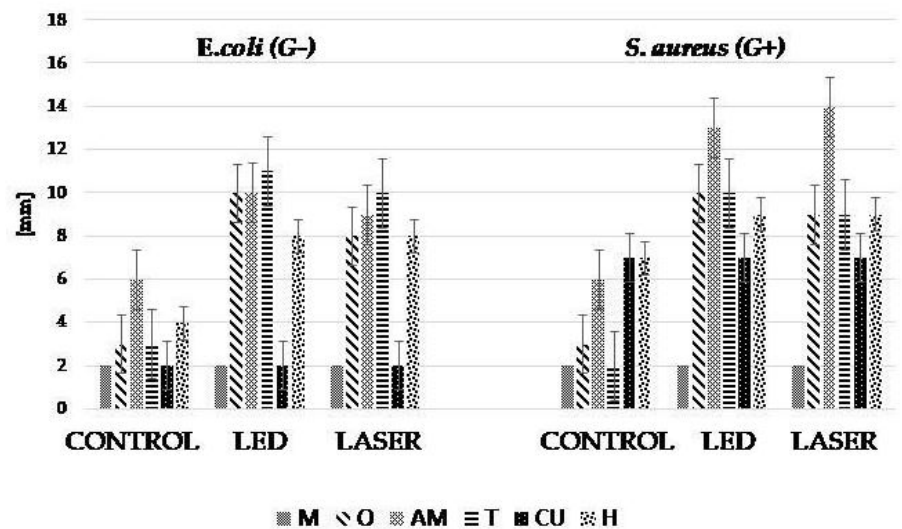
Figure 6. Antimicrobial activity of experimental PS—the diameters (mm) of the inhibition zone.